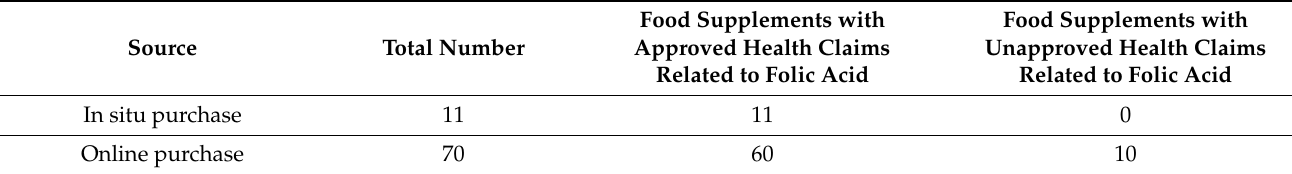
Table 2. Summary of the folic acid food supplements directed to pregnant women found in the Spanish market.